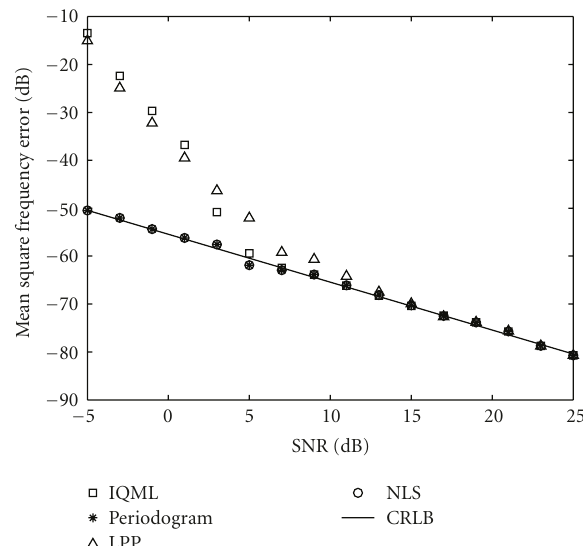
Figure 3: MSE for φ of single complex sinusoid at N = 20.